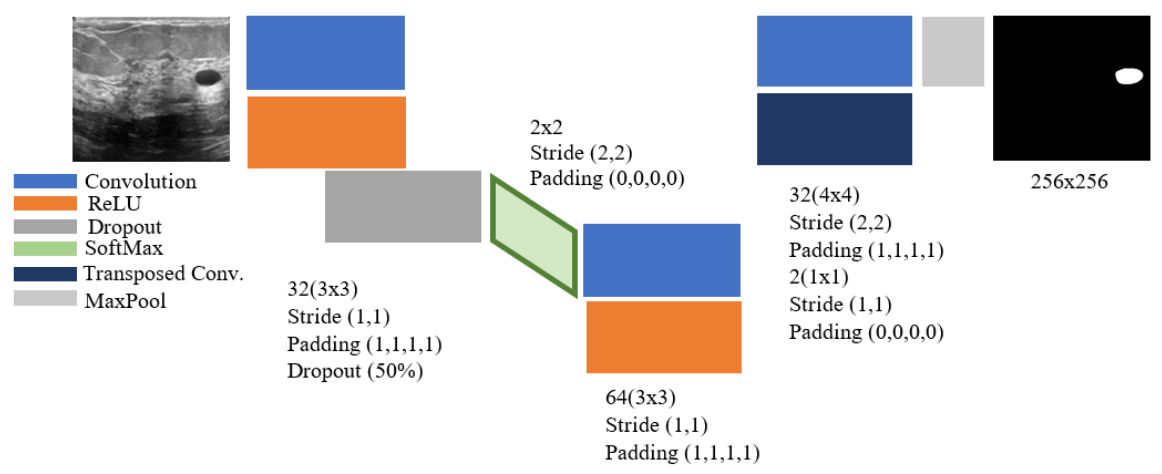
Figure 8. Presented CNN network architecture for the cancer tumor segmentation.